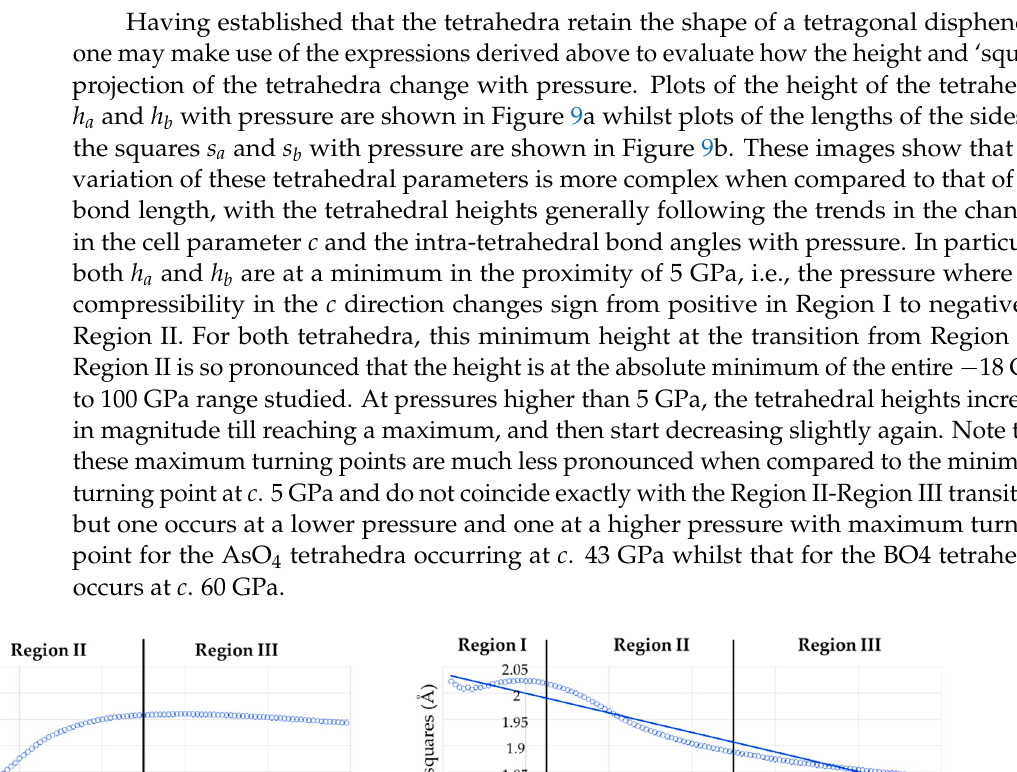
Figure 8. A plot of the sum of the six O-As-O intra-tetrahedral angles or six O-B-O angles pertaining to a single tetrahedron where it is shown that, subject to very minor discrepancies, the sum of angles always sums up to a constant value of c . 657°.